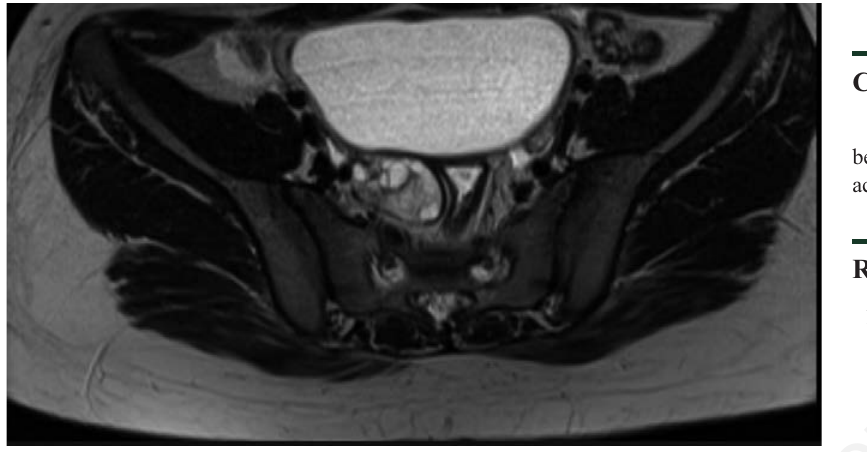
Figure 1. Magnetic resonance imaging of isolated tubal torsion.